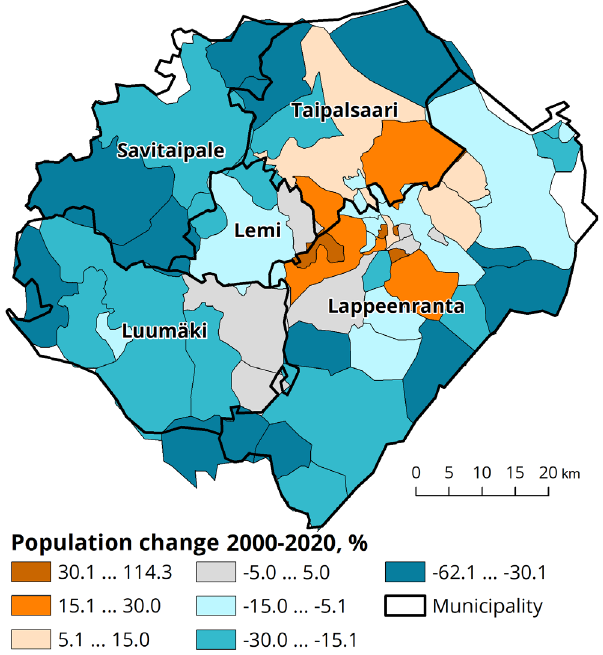
Fig. 6. An example of shrinking pockets at the postal code area level in terms of population (Lappeenranta sub-region).